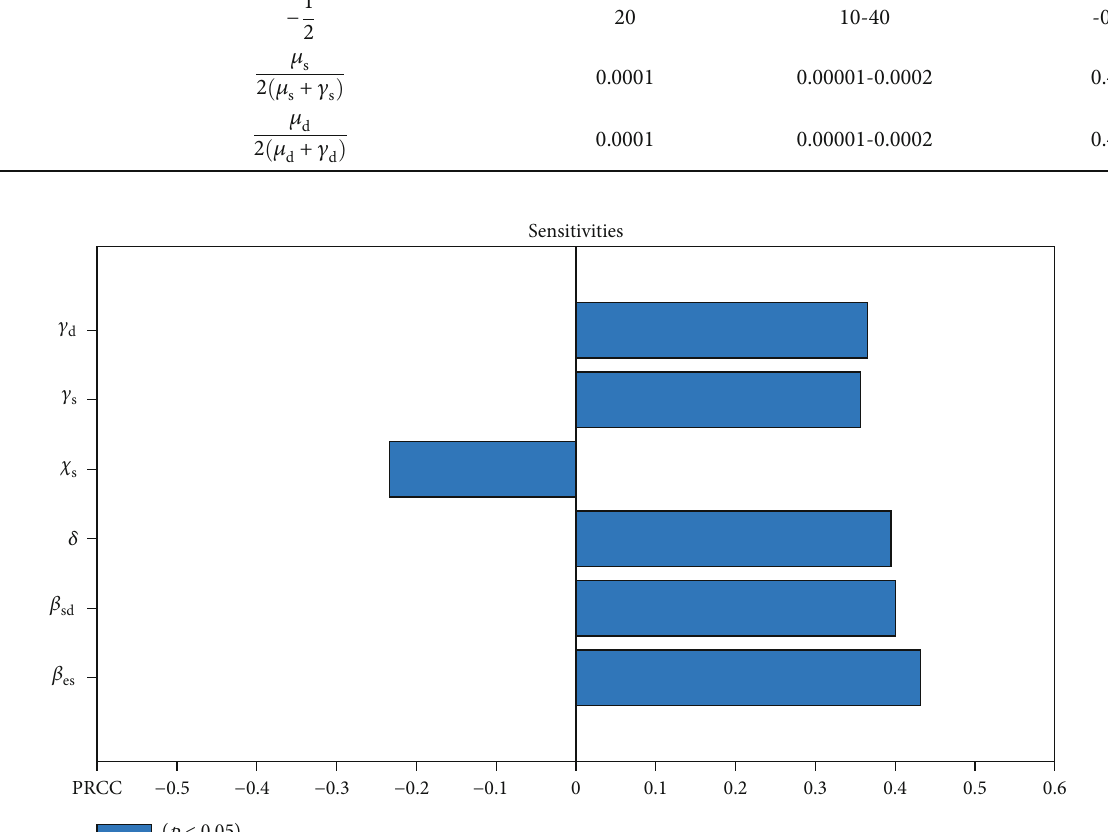
Figure 2: Global sensitivity analysis displaying the partial rank correlation coe ffi cients